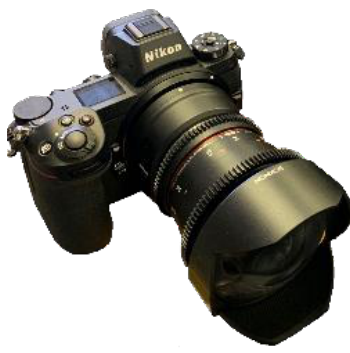
Figure 3. Nikon Z7 with the 14mm Rokion Cine DS Lensing.